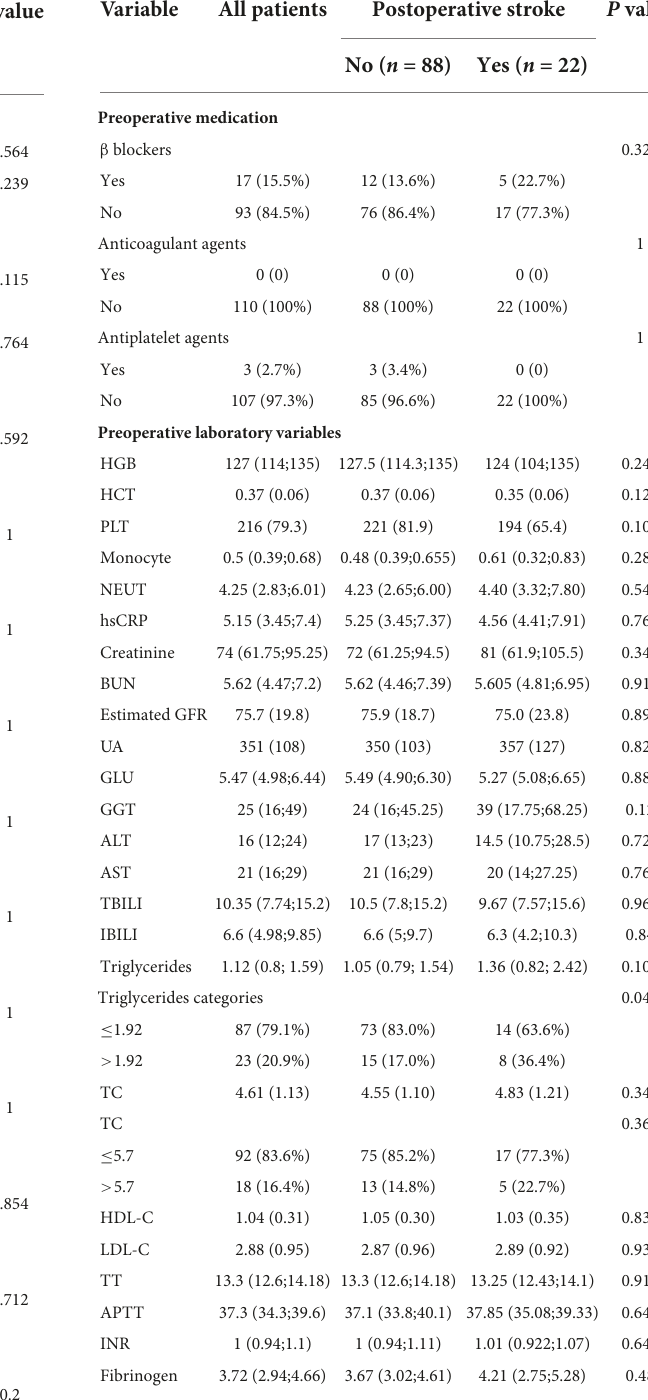
TABLE 1 Preoperative characteristics of patients between two